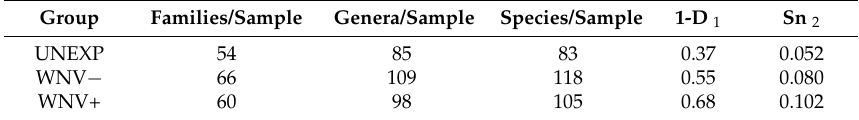
Figure 2. Relationship between the proportions of Wolbachia and Serratia in Cx. pipiens at seven days post blood feeding. Data points represent individual mosquitoes and the line represents the best-fit relationship resulting from linear regression analysis. A significant negative correlation was found (Pearson’s correlation, r = − 0.687, p < 0.0001).